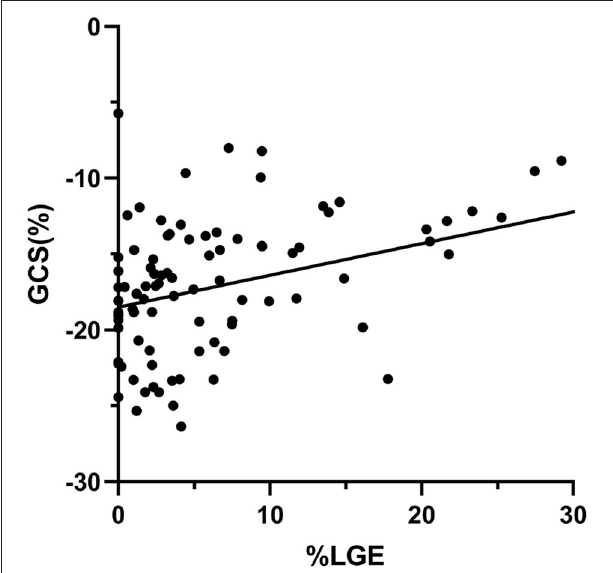
FIGURE 3 | Scatter plots of correlation analysis between GCS and %LGE. GCS and %LGE were correlated moderately ( r = 0.51, P < 0.001). GCS, global circumferential strain; LGE, late gadolinium enhancement.